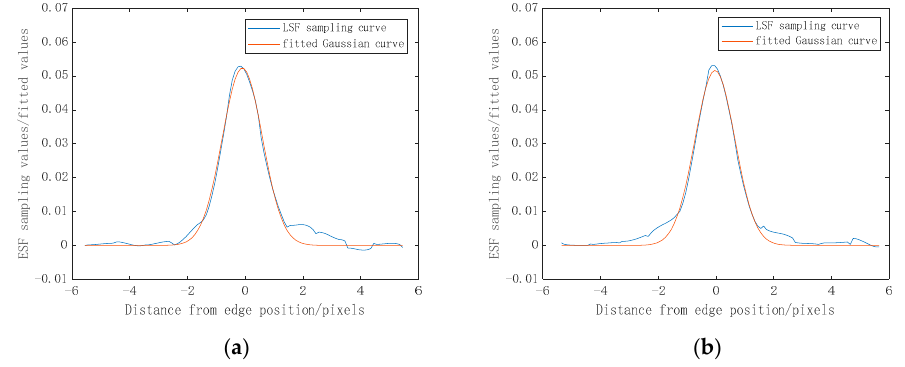
Figure 5. ( a ) Edge Spread Function (ESF) raw sample values, average values within each window, and smoothed curves in the horizontal direction and ( b ) ESF raw sample values, average values within each window, and smoothed curves in the vertical direction.